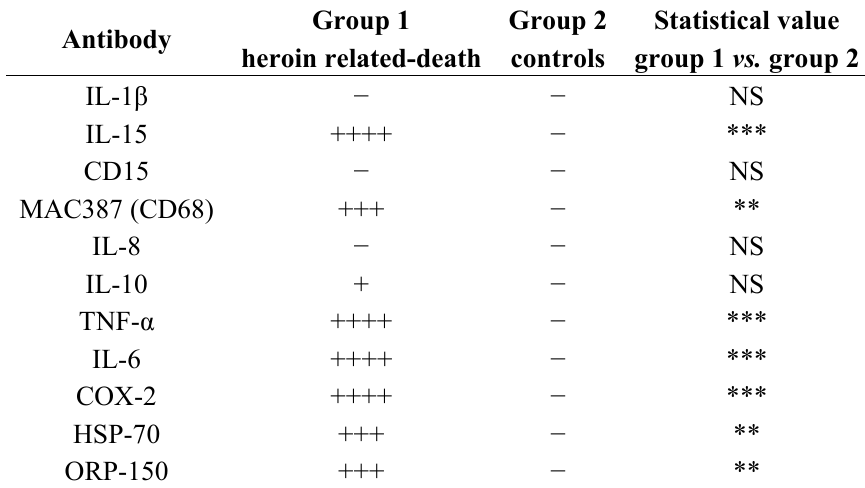
Table 1. Semi-quantitative evaluation and statistical analysis of the immunohistochemical findings and gradation of the immunohistochemical reaction in the brain samples. Group 1 Group 2 Statistical Antibody heroin related-death controls